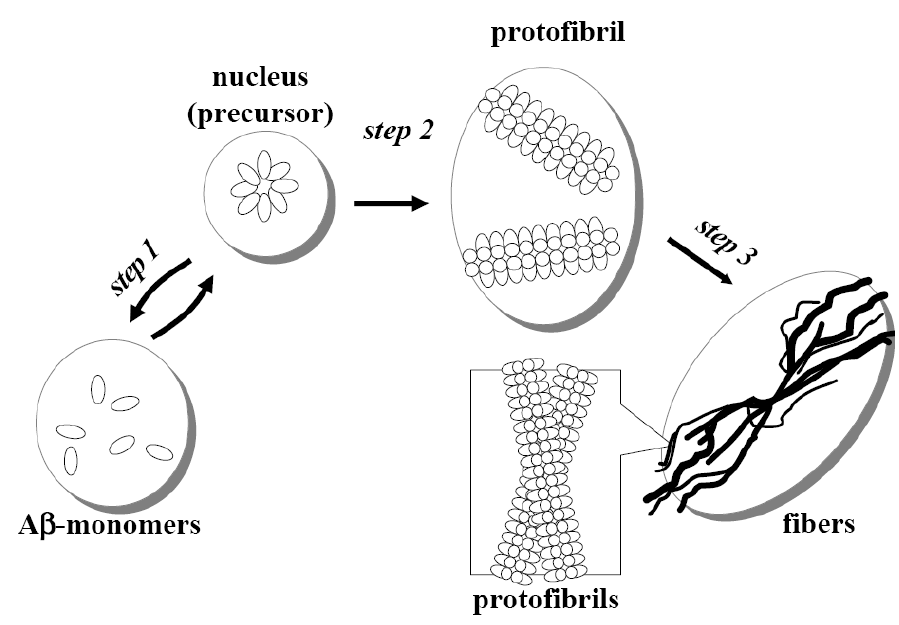
Figure 1. A model of fibrillogenesis. In step 1, monomeric A  forms nuclei from which protofibrils emanate (step 2). These protofibrils give rise to fill-length fibers (step